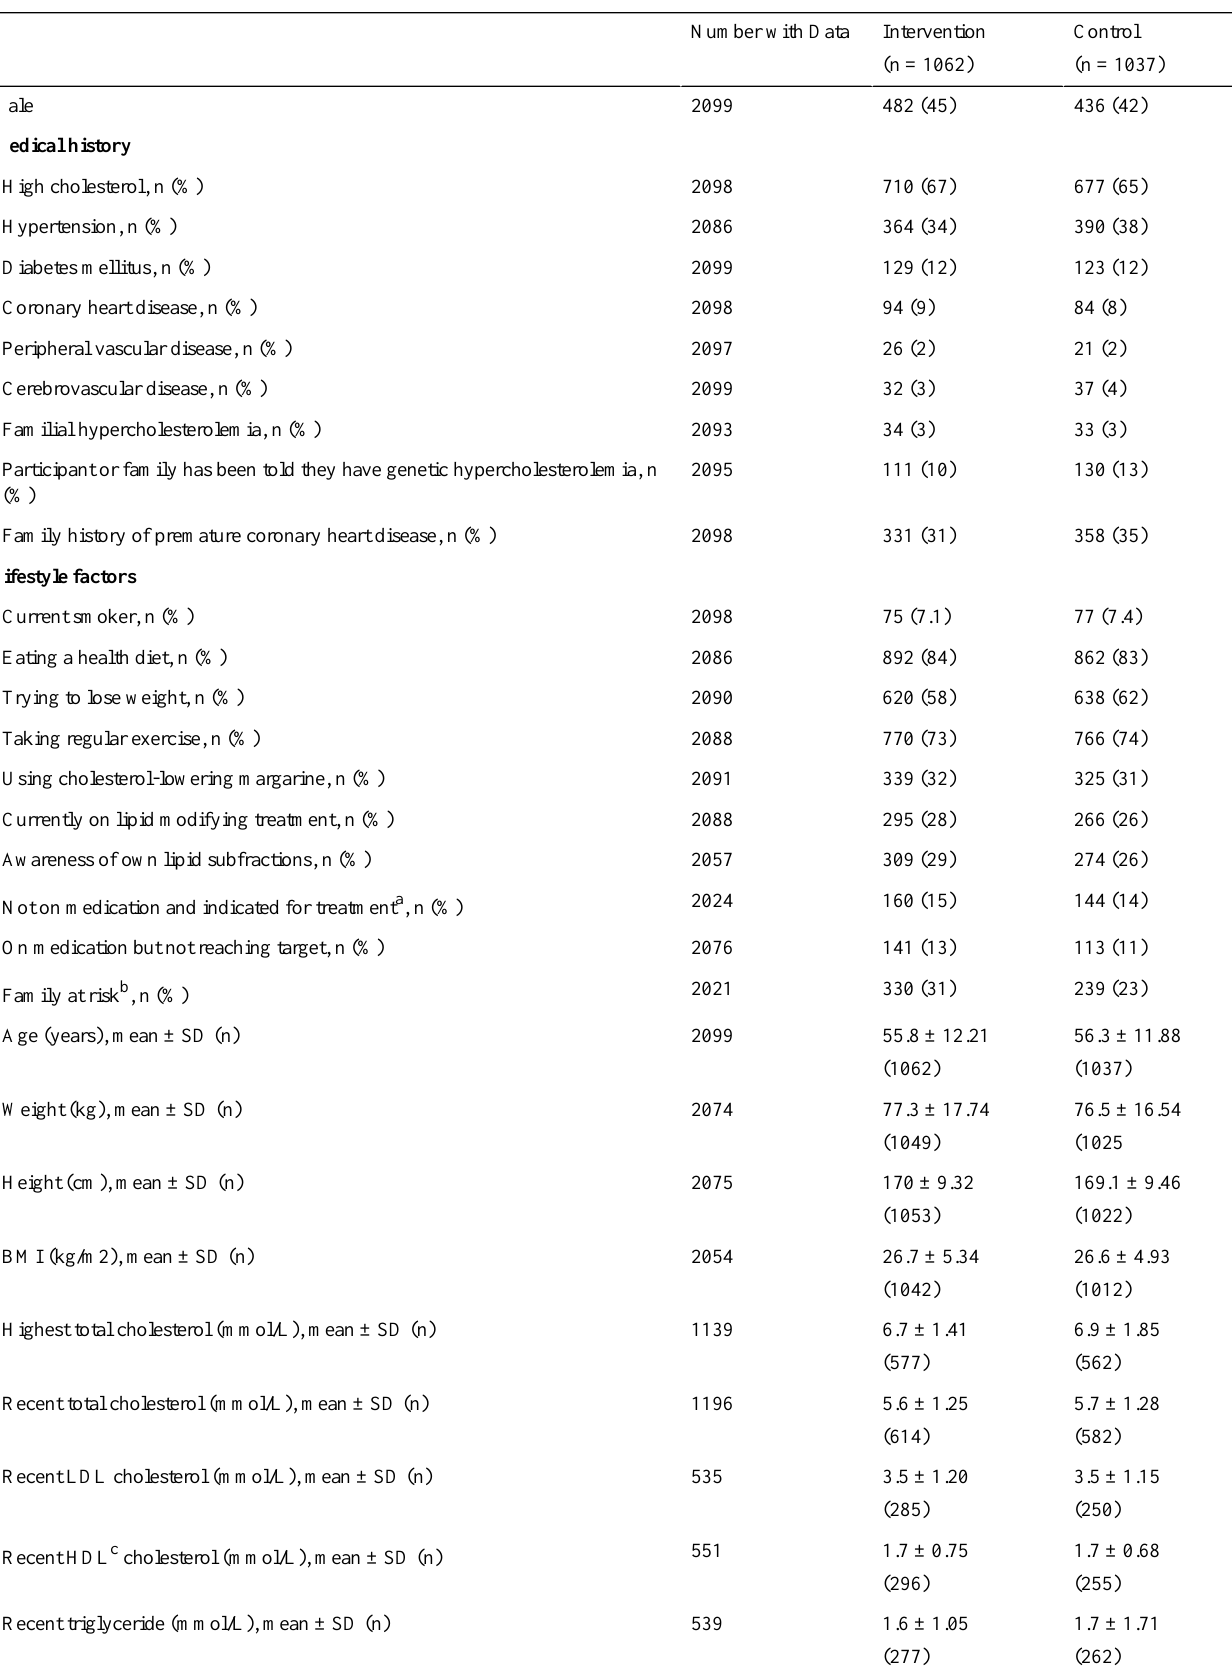
Table 1. Baseline characteristics of randomized participants